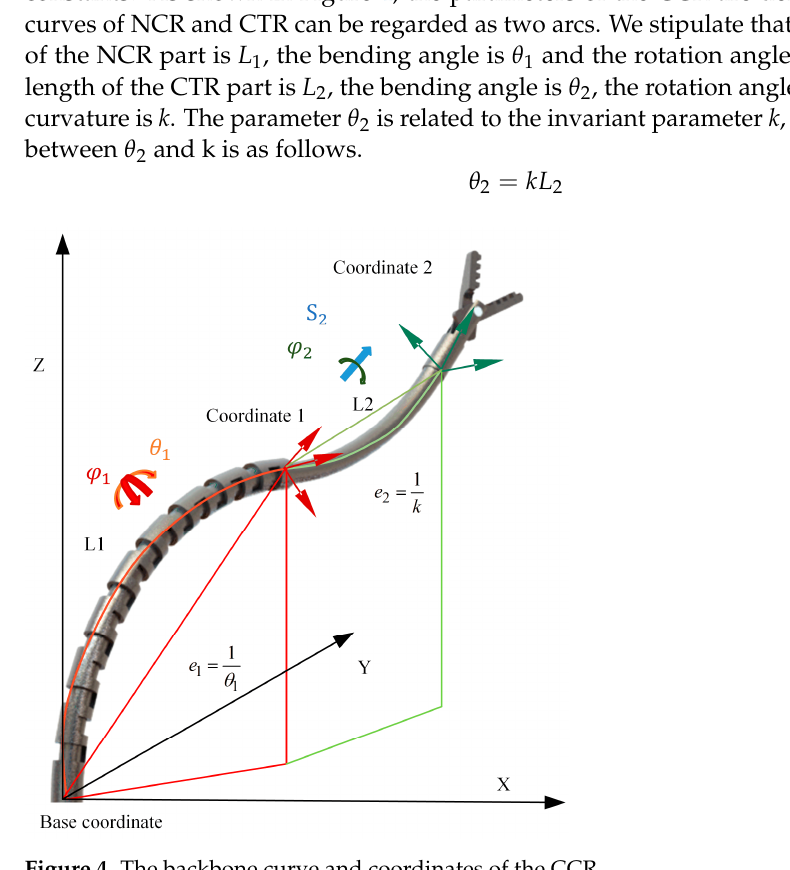
Figure 4. The backbone curve and coordinates of the CCR.